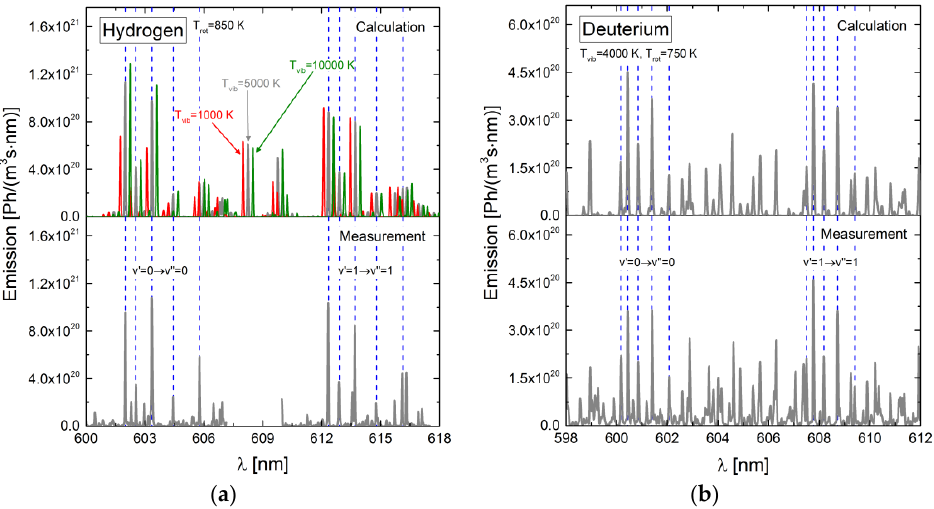
Figure 11. Spectra of the emission band d 3 → a 3 calculated by the Yacora corona model for molecular hydrogen and measured in an ionizing plasma: ( a ) hydrogen; ( b ) deuterium.